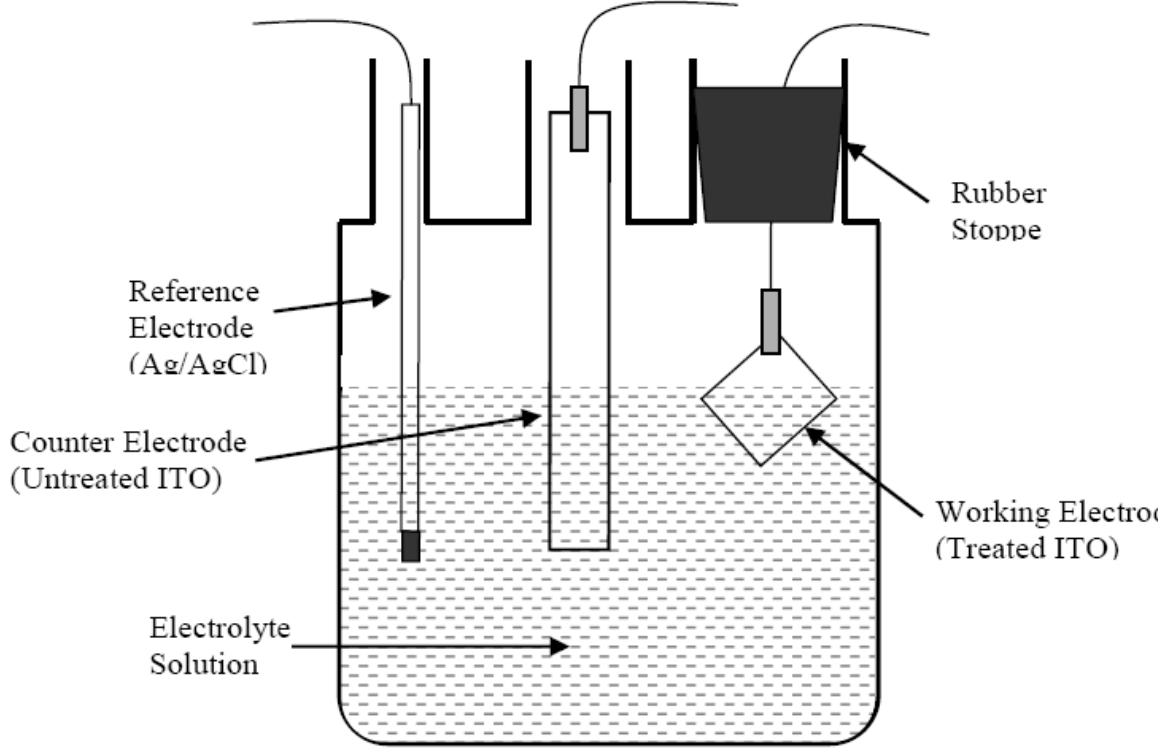
Figure 1. Three-electrode electrochemical cell with working electrode